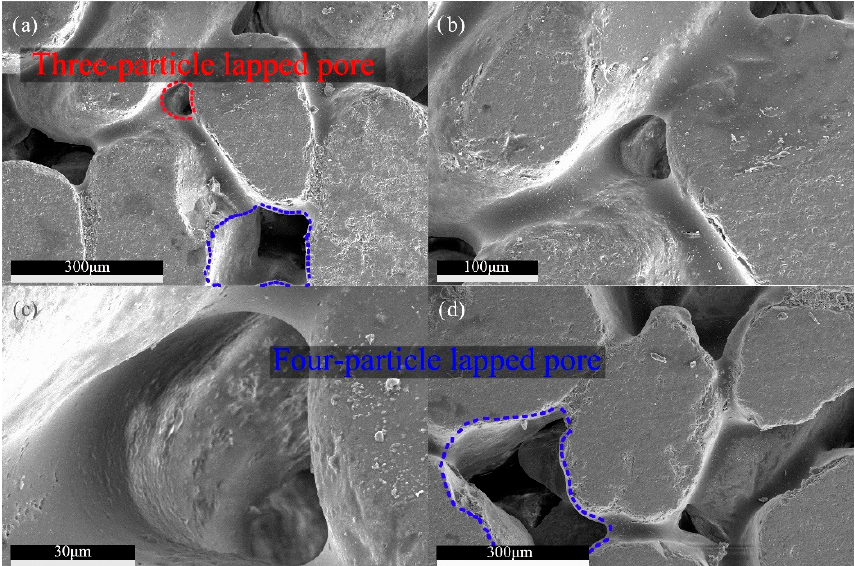
Figure 19. Pore structure characteristics of RBPB. ( a ) Three-particle overlapped pore. ( b ) Detail of the three-particle overlapped pore. ( c ) Internal detail of the three-particle overlapped pore. ( d ) Four-particle overlapped pore.